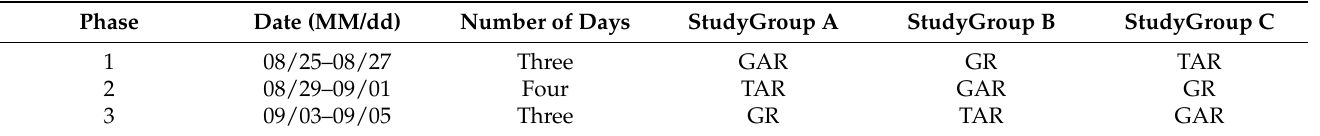
Table 4. Study groups and division of version of PATROL